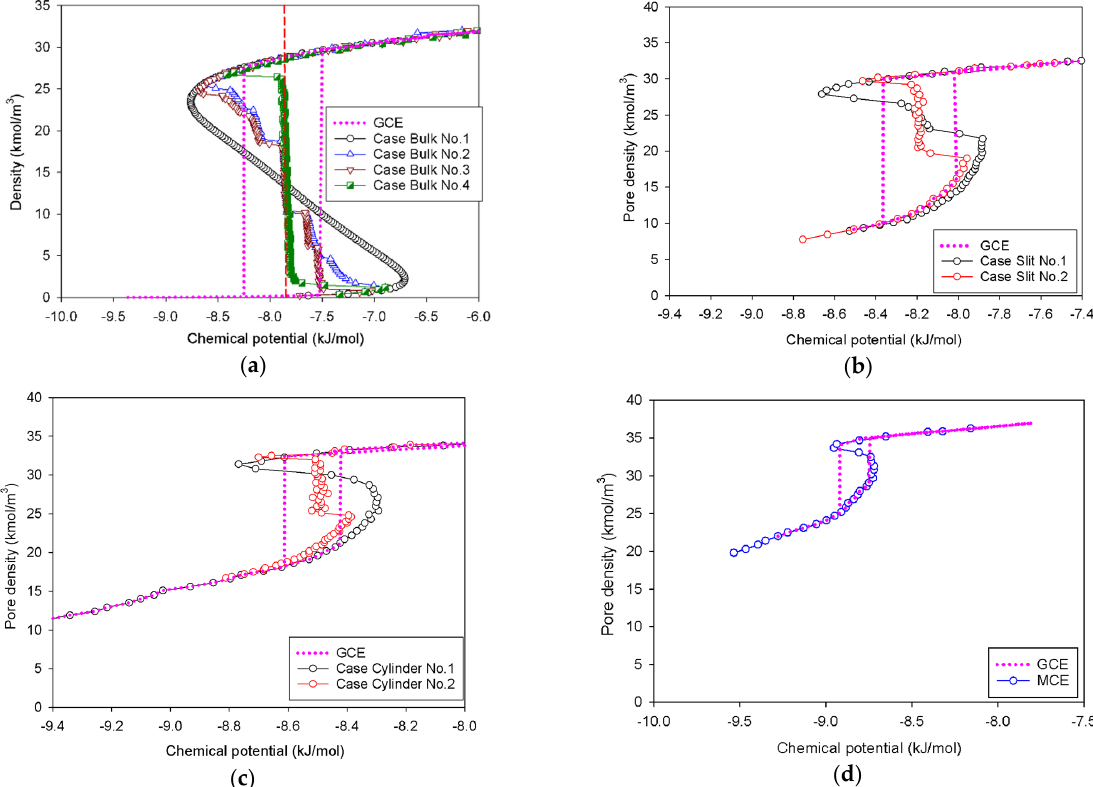
Figure 11. GCE and MCE isotherms of nitrogen with 2-LJ model: ( a ) bulk nitrogen at 77 K in four different cases, and nitrogen adsorption at 77 K in the ( b ) infinite slit pores, ( c ) cylindrical pores, and ( d ) spherical pores.